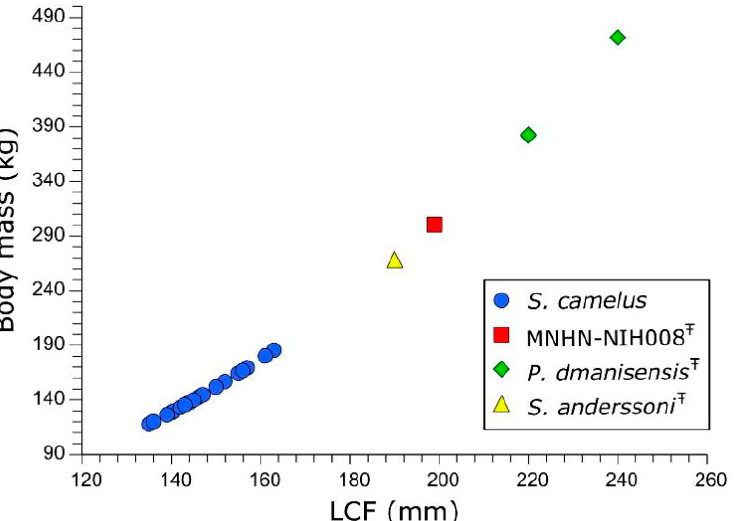
Figure 3. Body mass estimated from the minimum circumference of the shaft (LCF) for several fossil ostriches found in the Pleistocene of Eurasia, compared with the living Struthio camelus